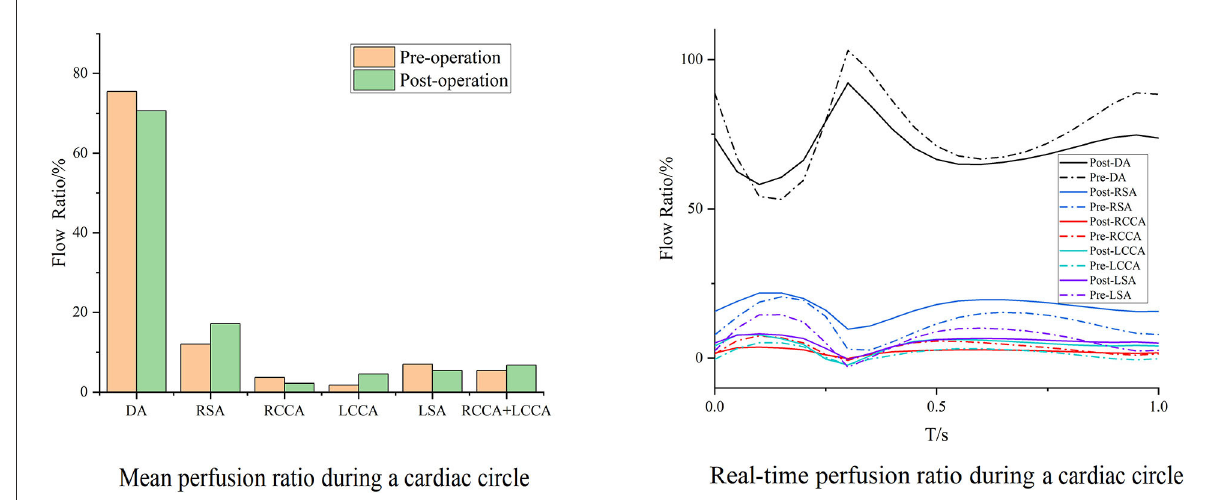
FIGURE5 Blood flow perfusion ratios of branches in Case 2. The bar graph illustrates the changes in the flow perfusion ratios in different branches. The curve figure illustrates the real-time perfusion within a cardiac cycle. Curves below the 0 level indicate backflow. DA, descending aorta; LCCA, left common carotid artery; RCCA, right common carotid artery; LSA, left subclavian artery; RSA, right subclavian artery.